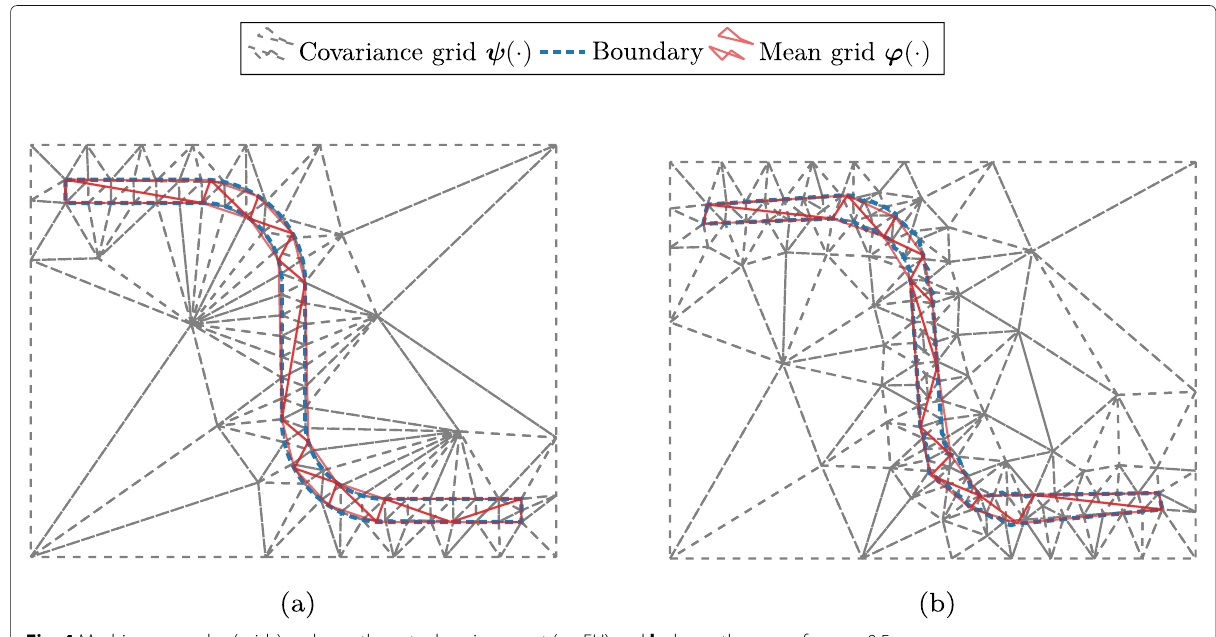
Fig. 4 Meshing examples (grids): a shows the actual environment (no EU) and b shows the case of σ EU = 0.5